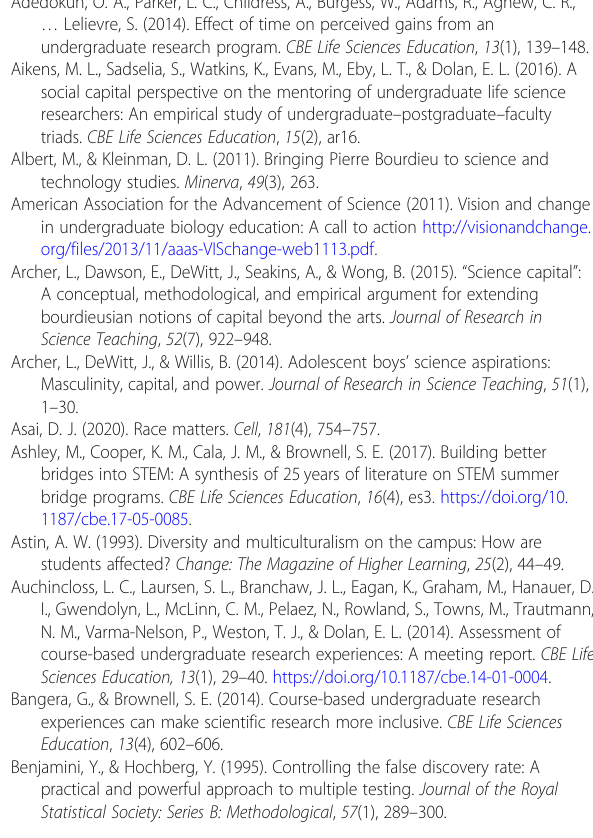
Abbreviations STEM: Science, technology, engineering, and math; R1: Research intensive; US: United States of